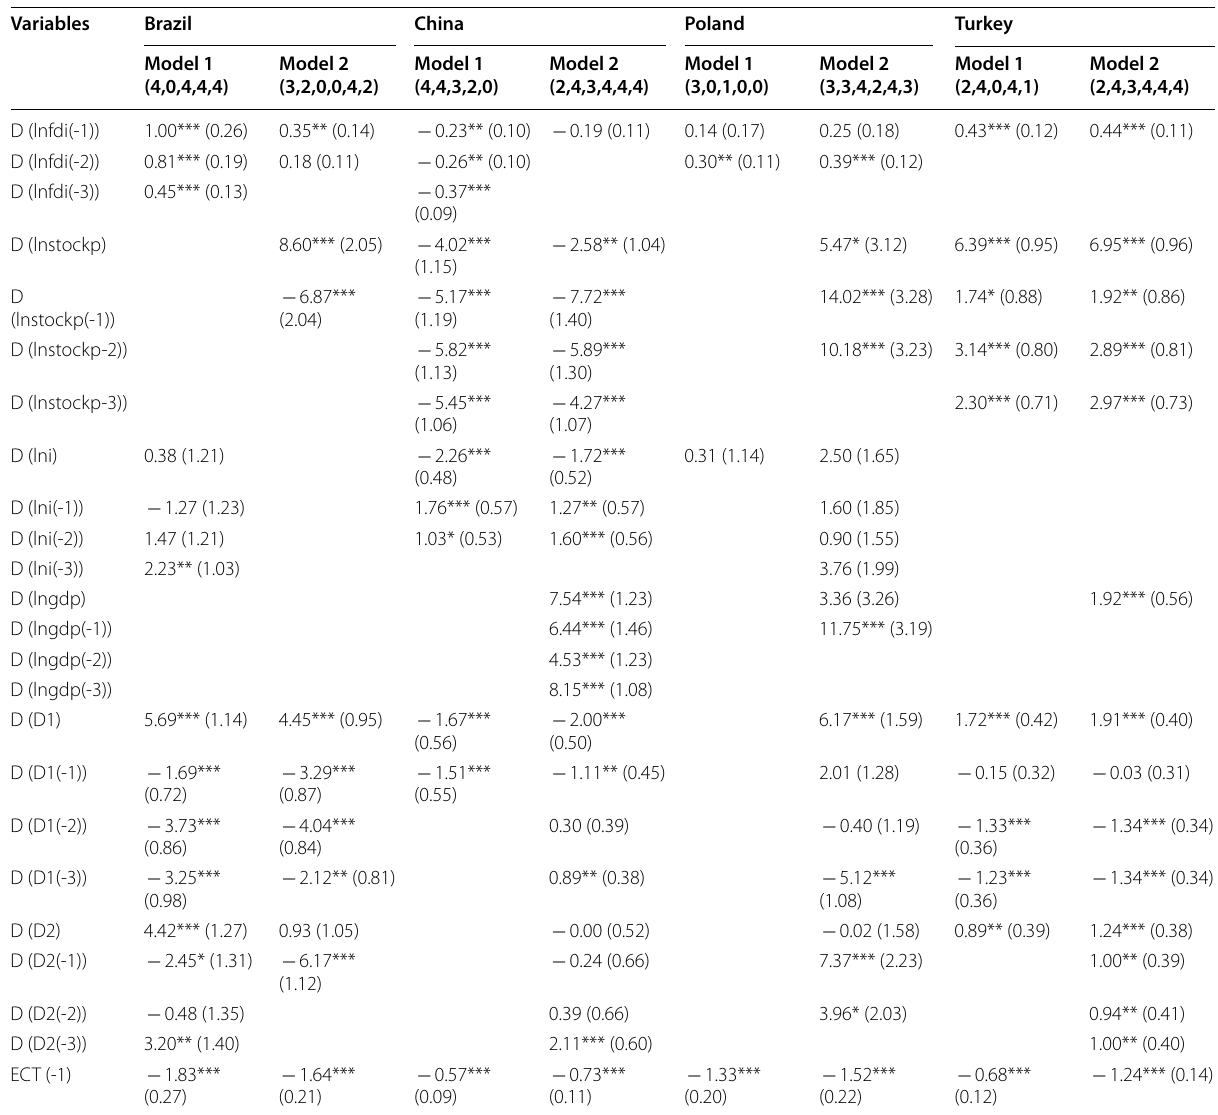
Table 5 Estimation results of error correction model